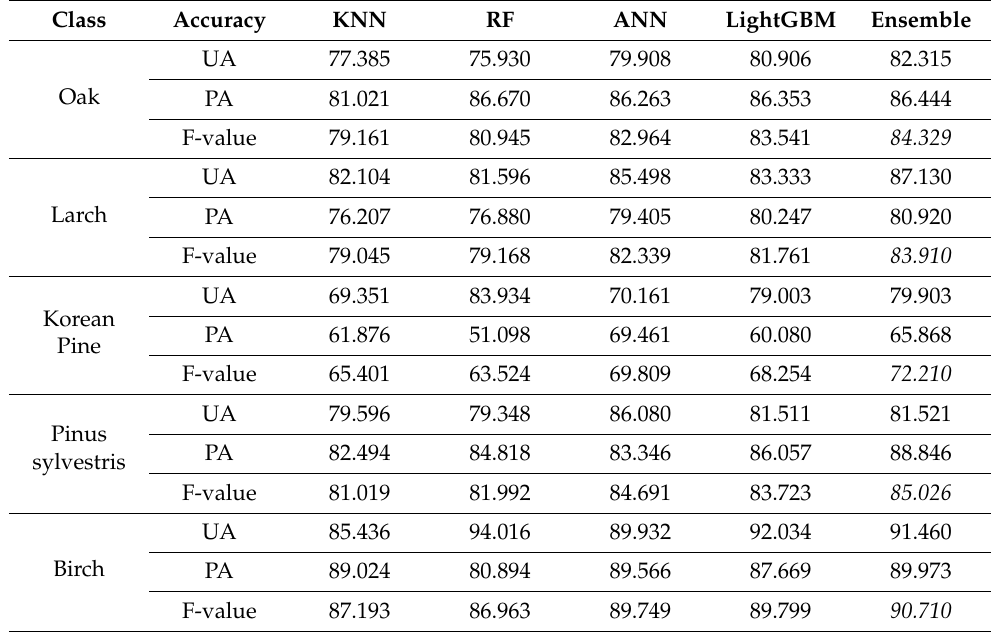
Table 8. Producer precision, user precision, and F-value (%) for each category for different methods in Experiment 7 (italics indicate the best result).